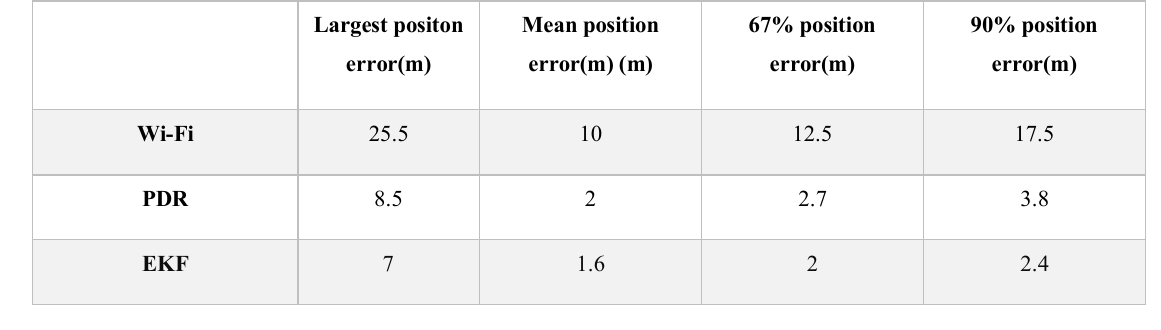
Table 2. Comparison of Algorithm Performance of positioning in the 3D